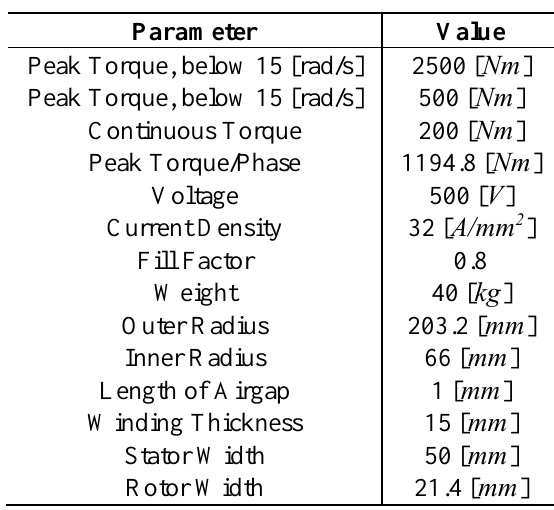
Figure 9. Motor torque optimization surface as a function of winding dimensions. Smaller wires permit more turns per pole, increasing the MMF and the torque. As the winding thickness increases, more copper can be added to the motor, but less backiron is available to conduct magnetic flux. Table 2. Optimized AFSRM